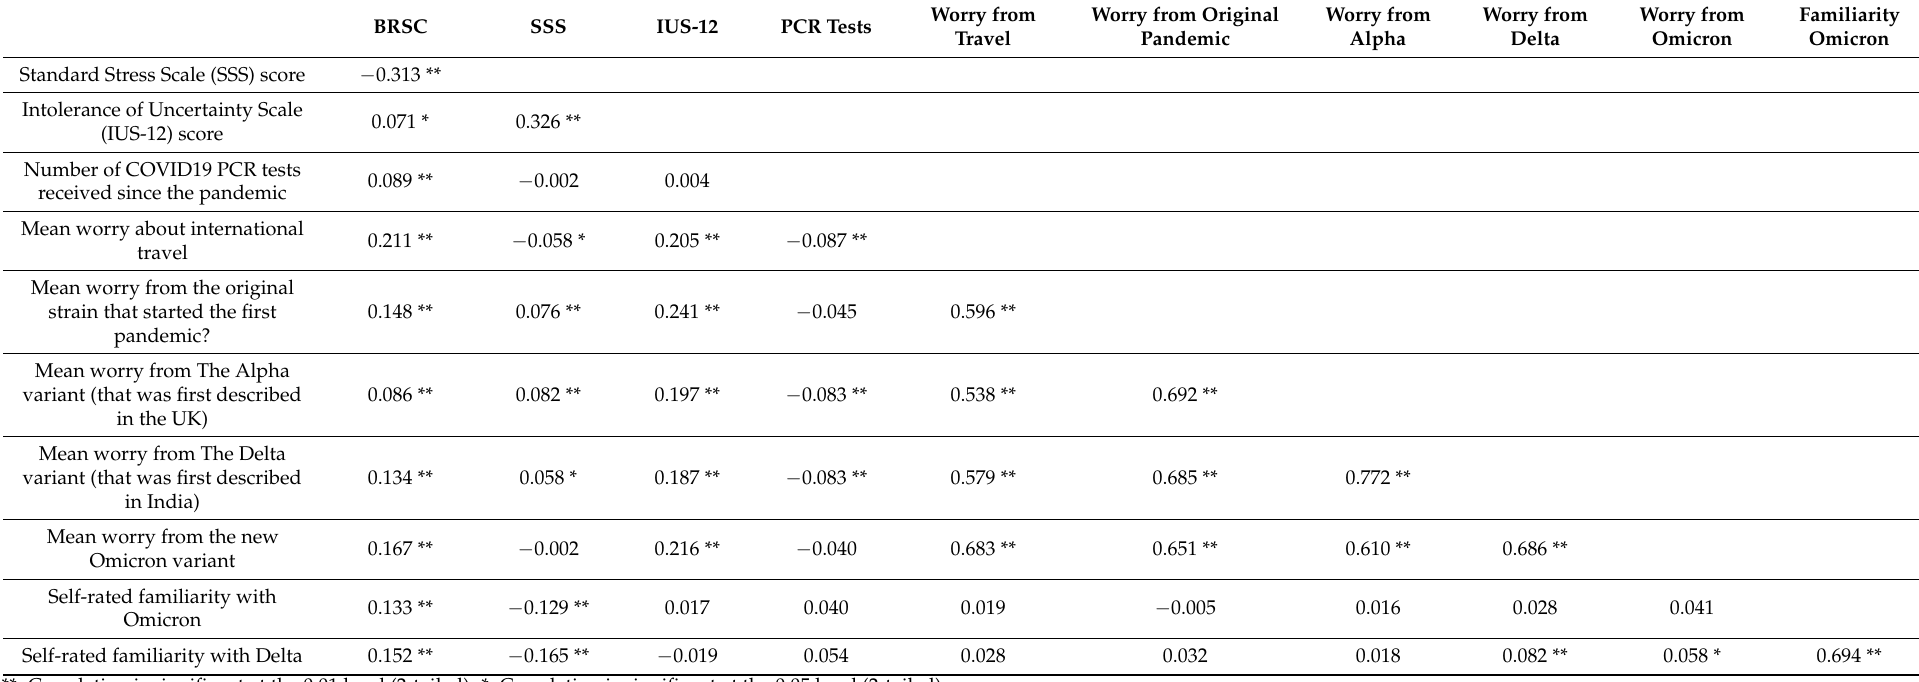
Table 5. Bivariate Correlations between the HCW’s measured